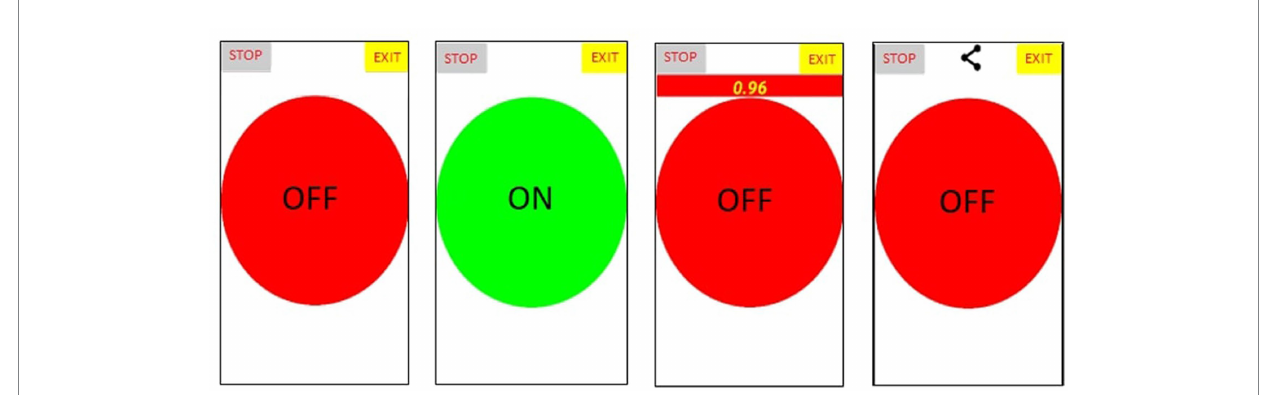
FIGURE 4 Task Attention Control (TAC) frontend (from left to right: 1 – Initial status; 2 – Running 15 min counter; 3 – Running acoustic alarm; 4 – Stopped and data export).